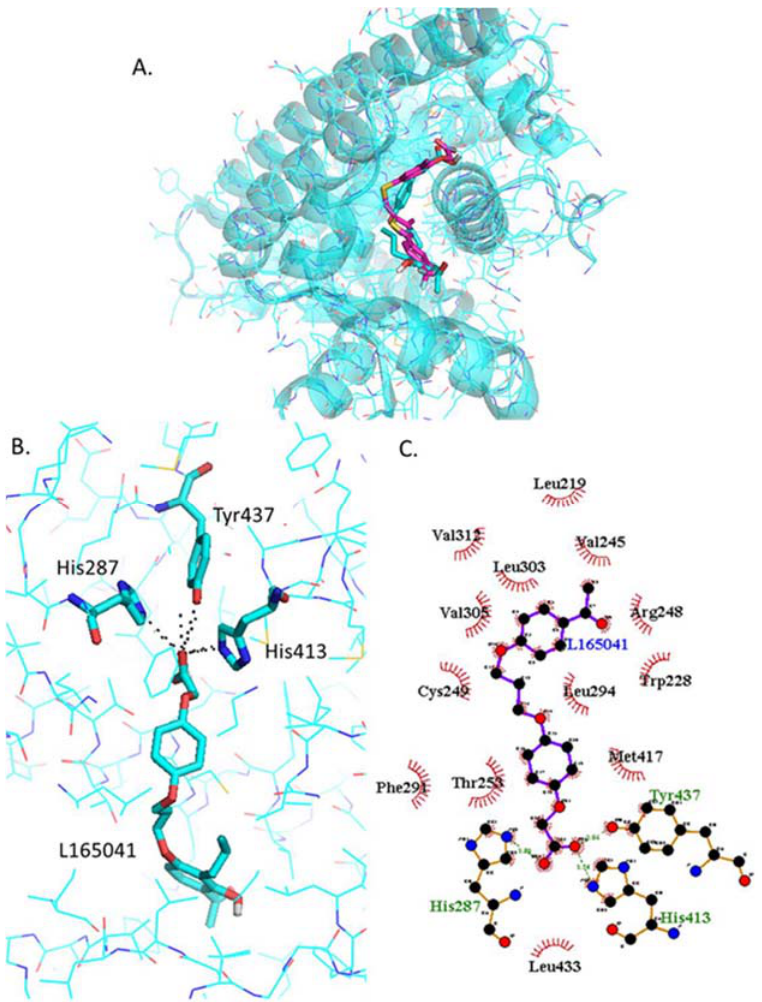
Figure 5. Analysis of L − 165042 docked into PPAR β / δ (PBD:3TKM). ( A ) Representation of the most stable L − 165041 docking conformation (cyan sticks) compared to the GW0742 of the crystal structure (pink). ( B ) 3D detail of the amino acids forming polar bindings with L − 165041 calculated by Pymol. Color coding of atoms: red O, Blue N, mustard S, white F, pink C of GW0742 from the crystal structure, cyan sticks C of L − 165041 docked into the crystal structure, cyan lines C from PPAR β / δ . ( C ) Schematic 2D representation of the interaction between PPAR β / δ LBD and - L − 165041 calculated using Ligplot+. The green dashed lines indicate polar interactions and the red spoked arcs indicate hydrophobic interactions. Colour coding of atoms: red O, blue N, yellow S, green F, black C.